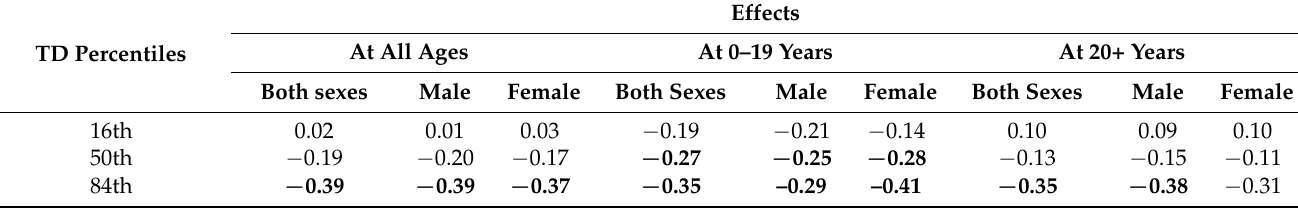
Table 5. Conditional direct effect(s) of the RSTG on the prevalence of asthma.